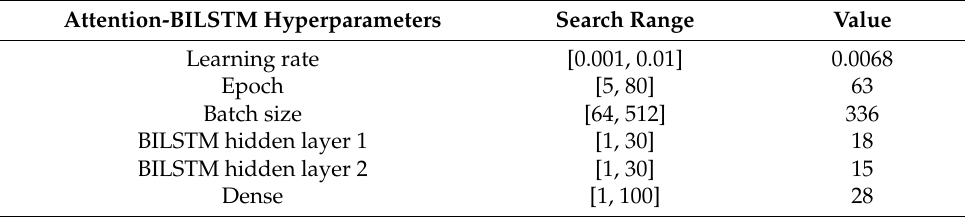
Table 4. The search range and results of each parameter in iterations. Attention-BILSTM Hyperparameters